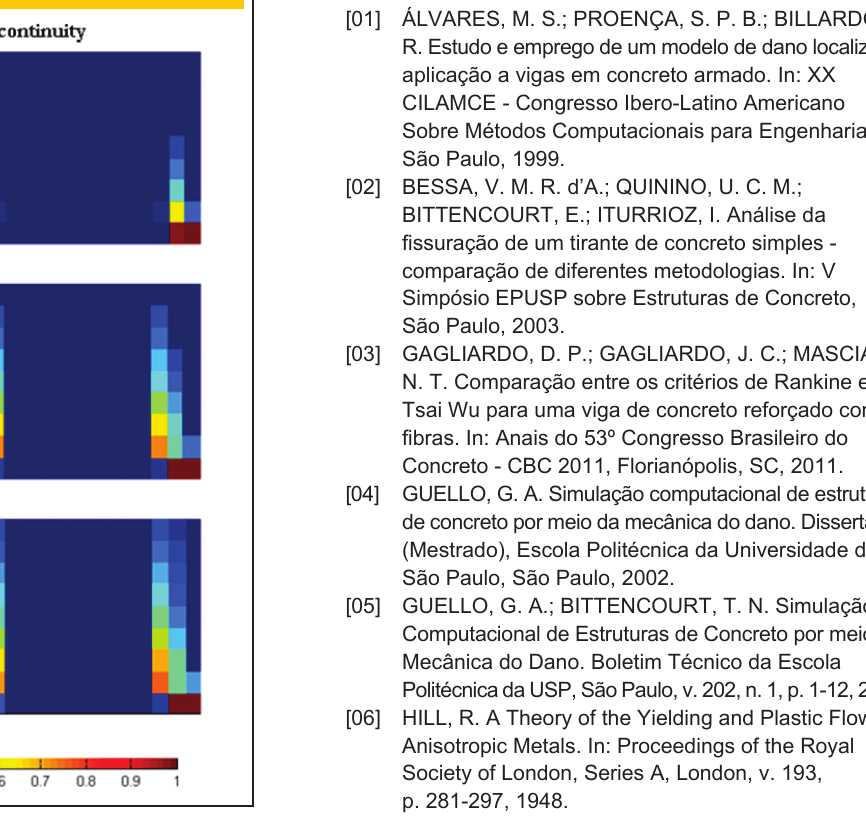
Figure 5 – Damage distribution in the concrete in the half part of the pull rod with discontinuity for: a)  = 0.00005; d0 b)  = 0.00003; e  = 0.00001